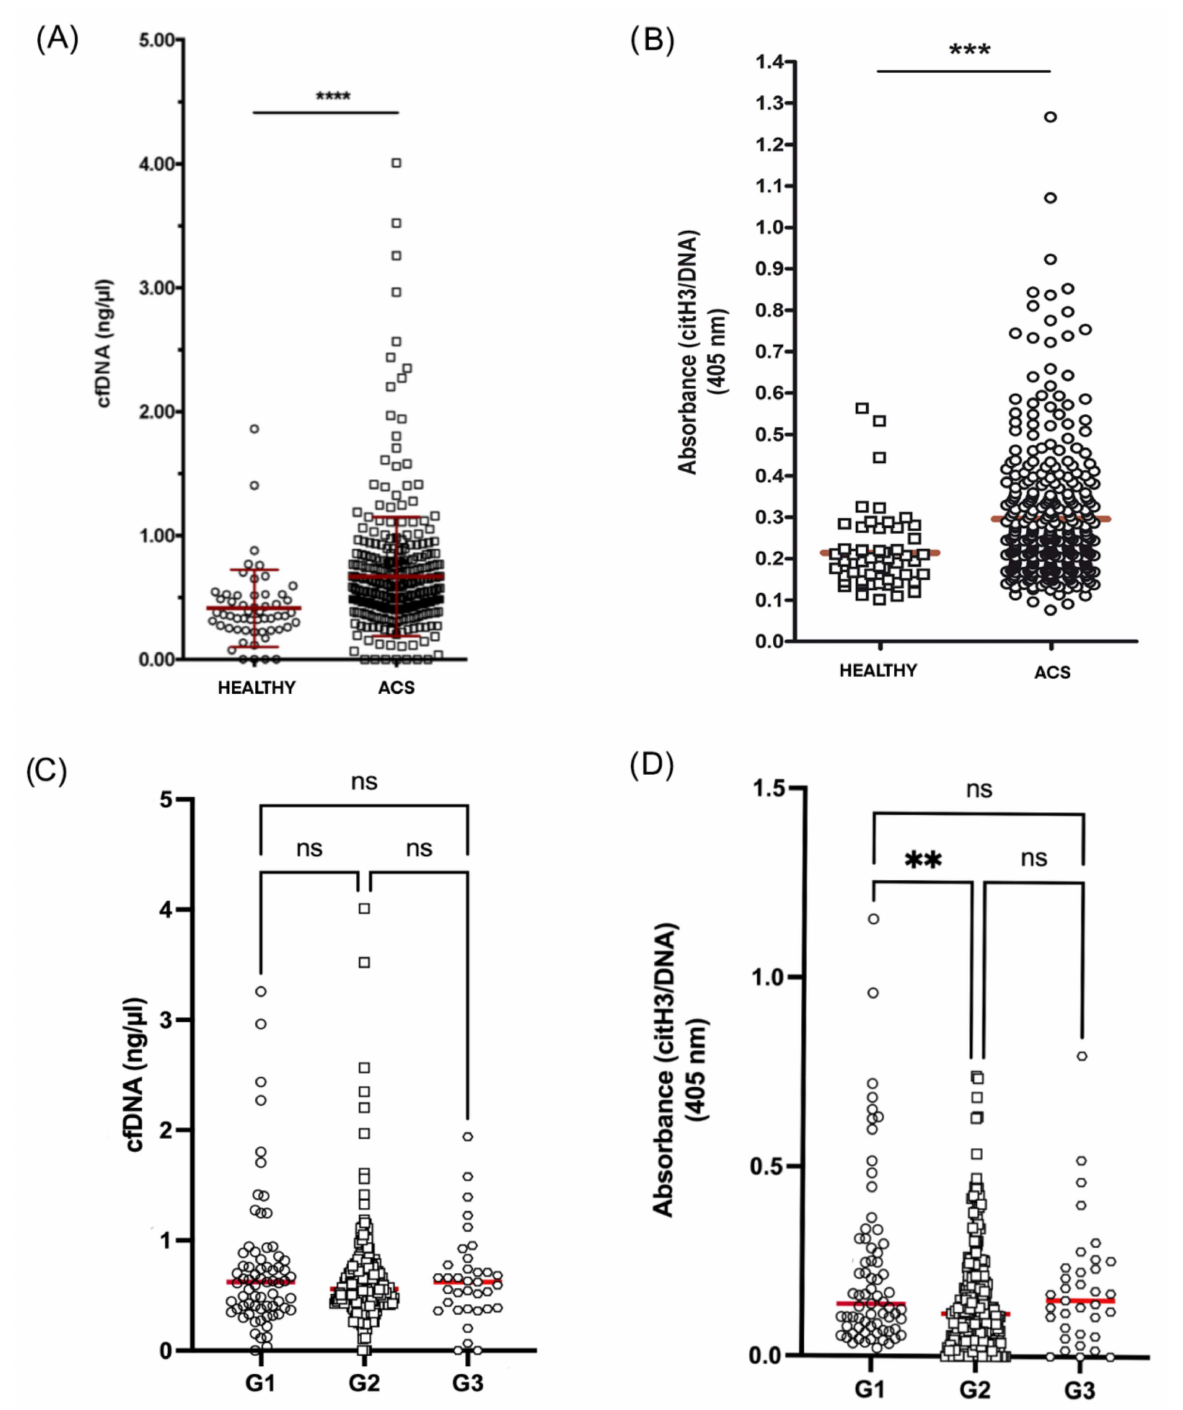
Figure 1. Levels of NETosis markers in ACS young patients. ( A ) cfDNA levels in healthy donors (n = 55) vs. ACS patients (n = 342) measured by Sytox Green fluorescence. ( B ) citH3–DNA complexes in healthy individuals (n = 51) vs. ACS patients (n = 343) measured by ELISA and expressed as relative absorbance at 405 nm. ( C ) cfDNA levels by group of ACS patients (G1 n = 69; G2 n = 238; G3 n = 35). ( D ) citH3–DNA complexes expressed as relative absorbance at 405 nm in the different groups of ACS patients (G1 n = 69; G2 n = 239; G3 n = 35). ns: not significant; ** p < 0.01; *** p < 0.001; **** p <